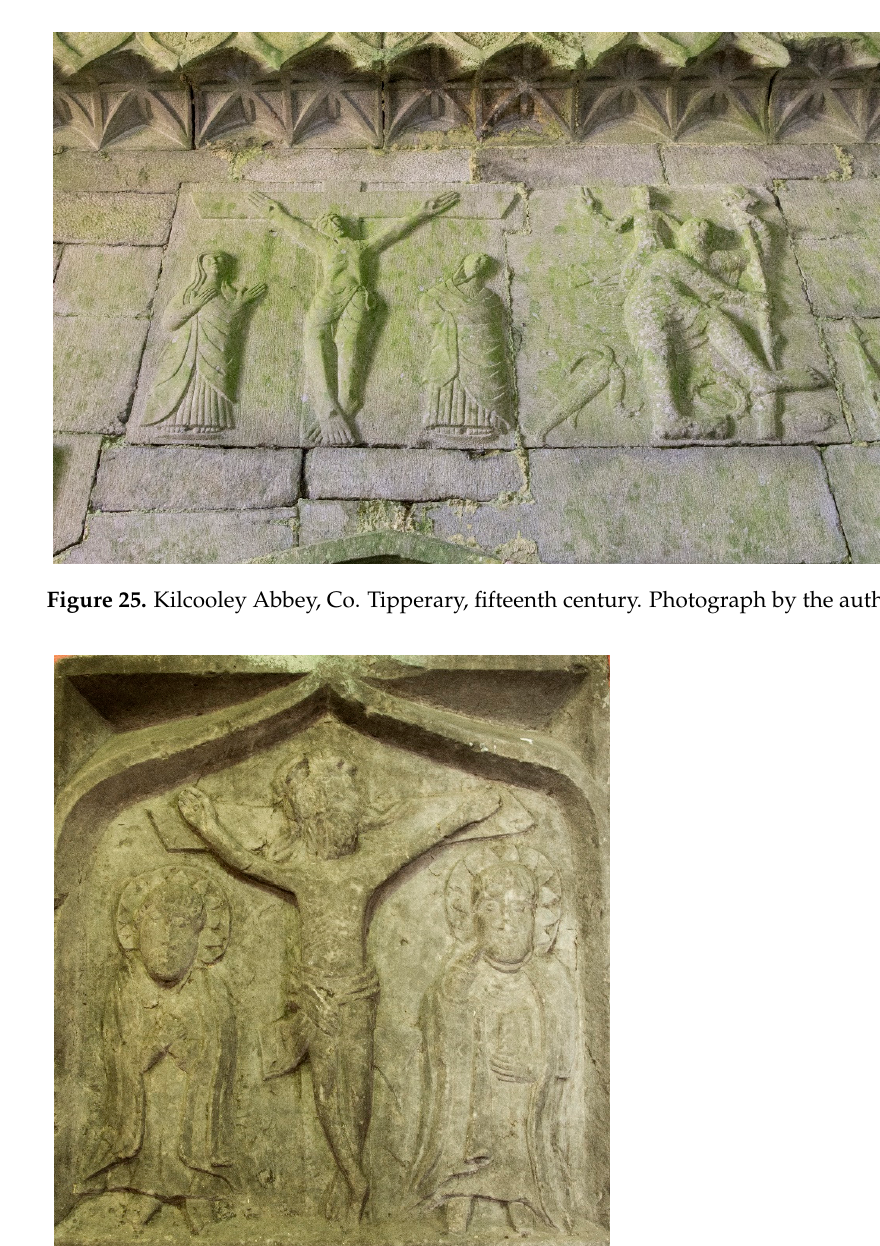
Figure 26. Tomb chest, Carmelite Priory, Co. Kildare, sixteenth century. Photograph by the author.